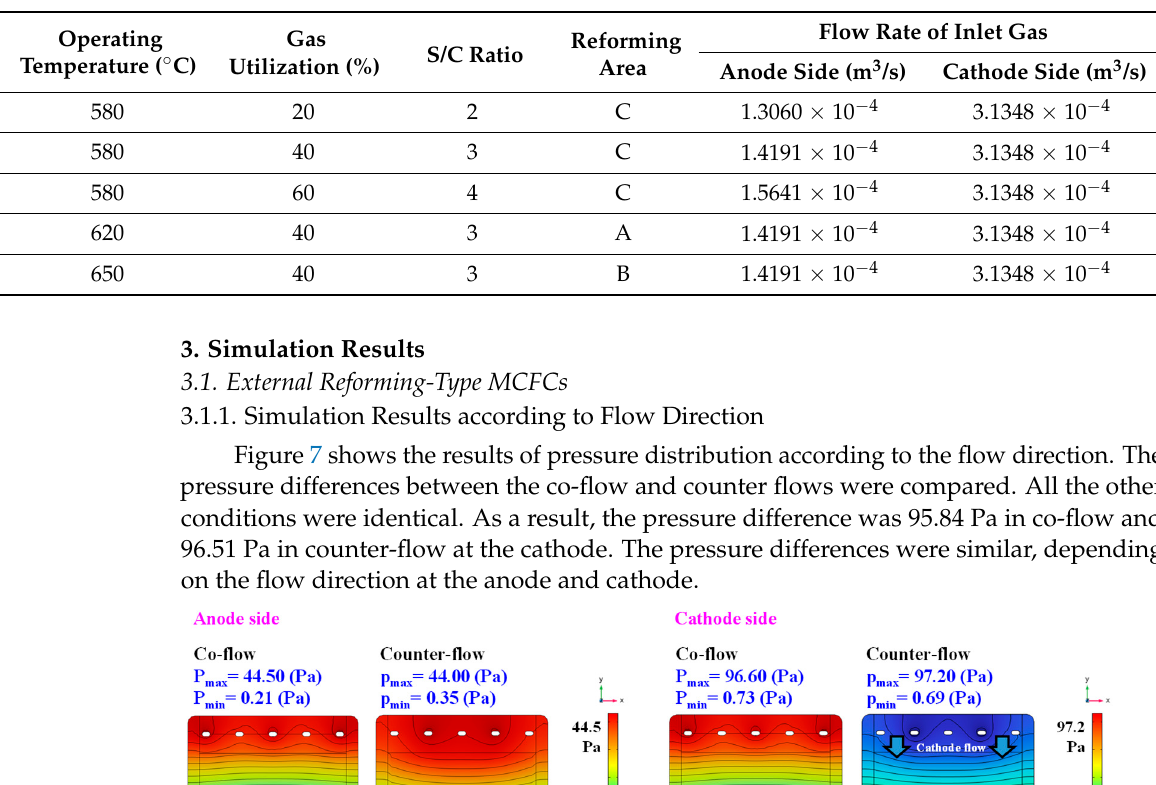
Table 4. Flow rate of inlet in the operating conditions of internal reforming-type MCFCs.